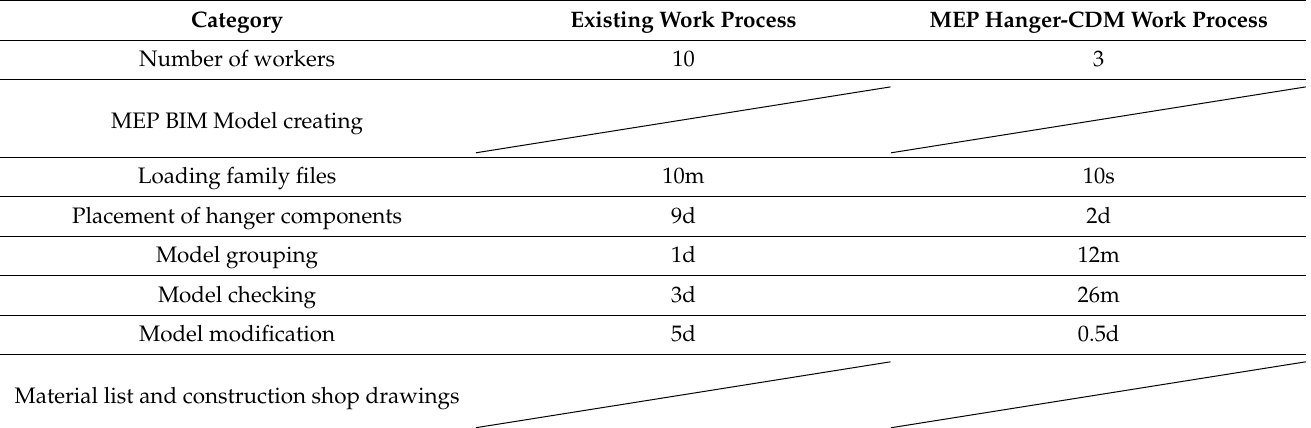
Table 3. Time measurement results of the work